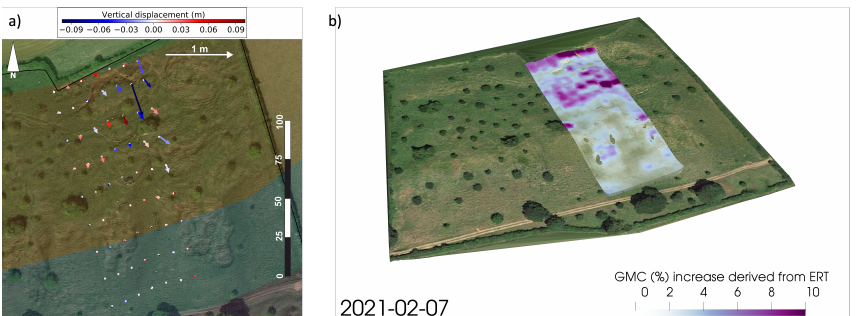
Figure 8. ( a ) Motion of the pegs during the January 2021 event (between 18 November 2020 and 19 February 2021). ( b ) Moisture increase derived from Electrical Resistivity Tomography (ERT) during the 2021 January